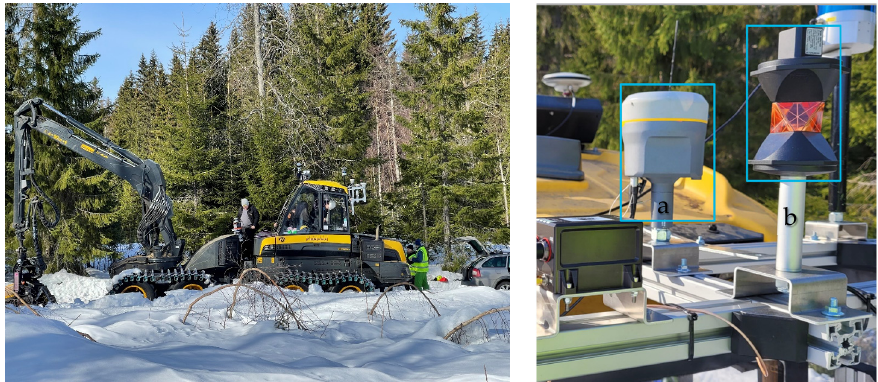
The Trimble R12 GNSS receiver was used to collect multi-constellation GNSS data.